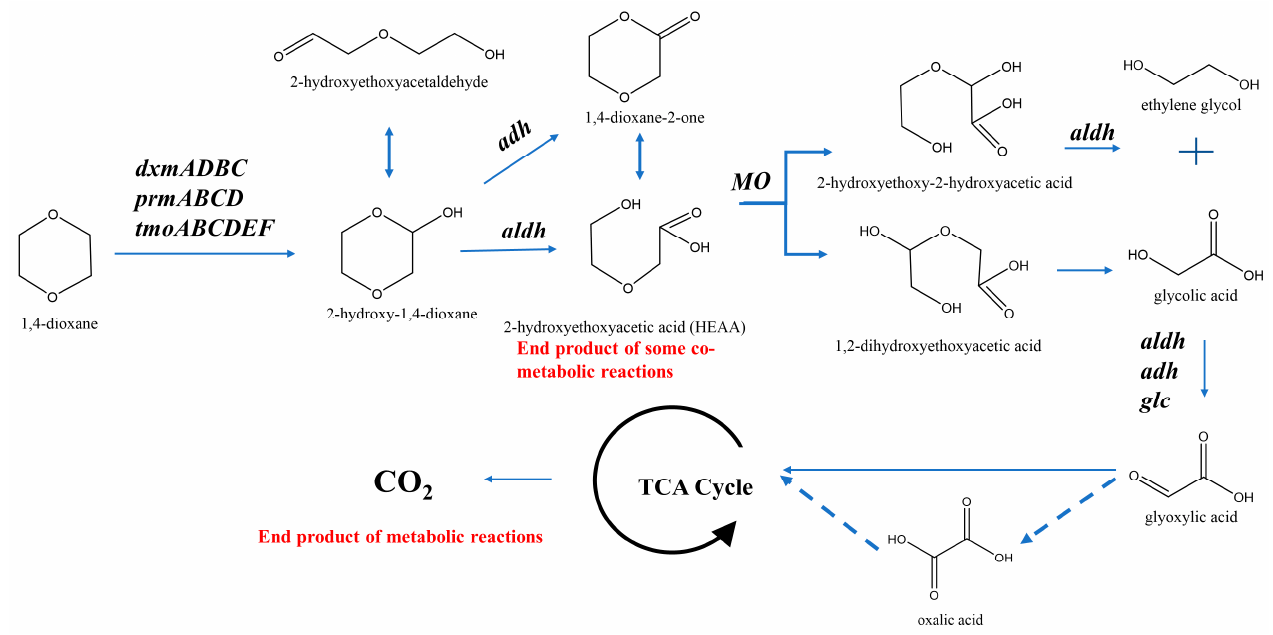
Figure 2. Biodegradation pathways and associated genes of 1,4-dioxane biodegradation. dxmADBC , dioxane monooxygenase; prmABCD , propane monooxygenase; tmoABCDEF , toluene